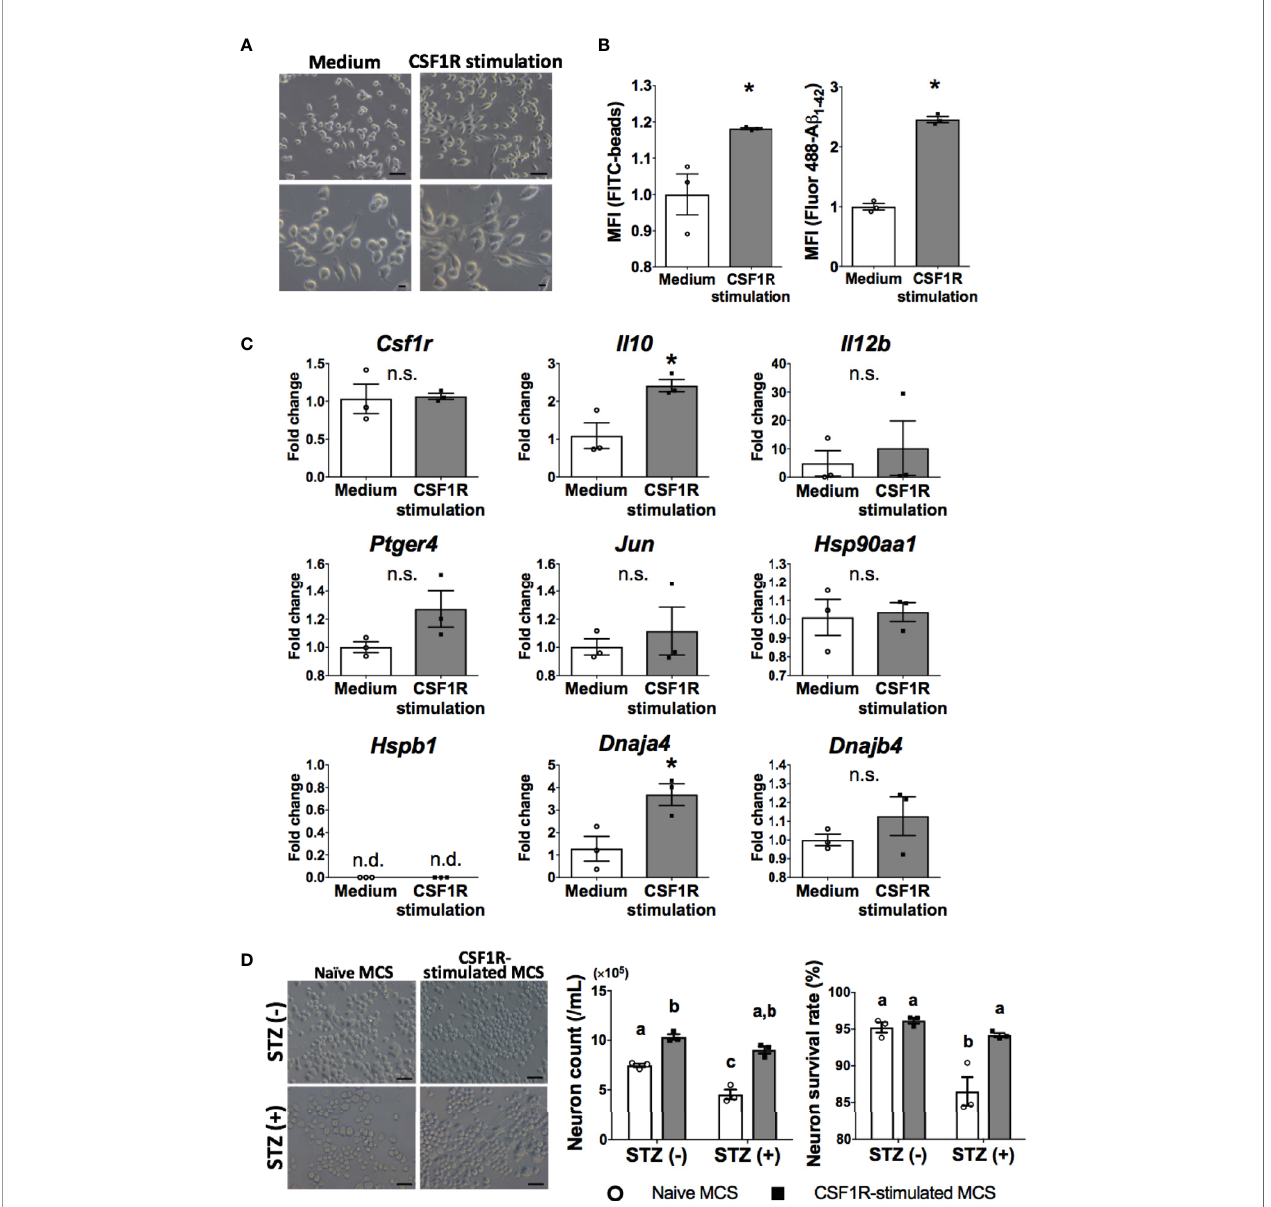
FIGURE 5 | Neuroprotective microglia are transformed by CSF1R signaling. (A) Dendrite protrusion of CSF1R-stimulated microglia. Bars, 50 (upper) and 10 m m (lower). (B) Promoted phagocytosis of CSF1R-stimulated microglia. (C) Upregulation of neuroprotective genes in CSF1R-stimulated microglia. (D) Prevention of diabetes-induced neuronal death by CSF1R-stimulated MCS. Bar, 50 m m. Means ± SE are presented. *p or a,b p < 0.05 for Student ’ s t test or two-way ANOVA with Sidak multiple comparisons. MCS, microglia culture supernatant. n.s., not signi fi cant; n.d., not detected. a,b,c p < 0.05 for two-way ANOVA with Sidak multiple comparisons. The different letters (the symbols of a, b, c) indicate statistically signi fi cant difference between groups in multiple comparison